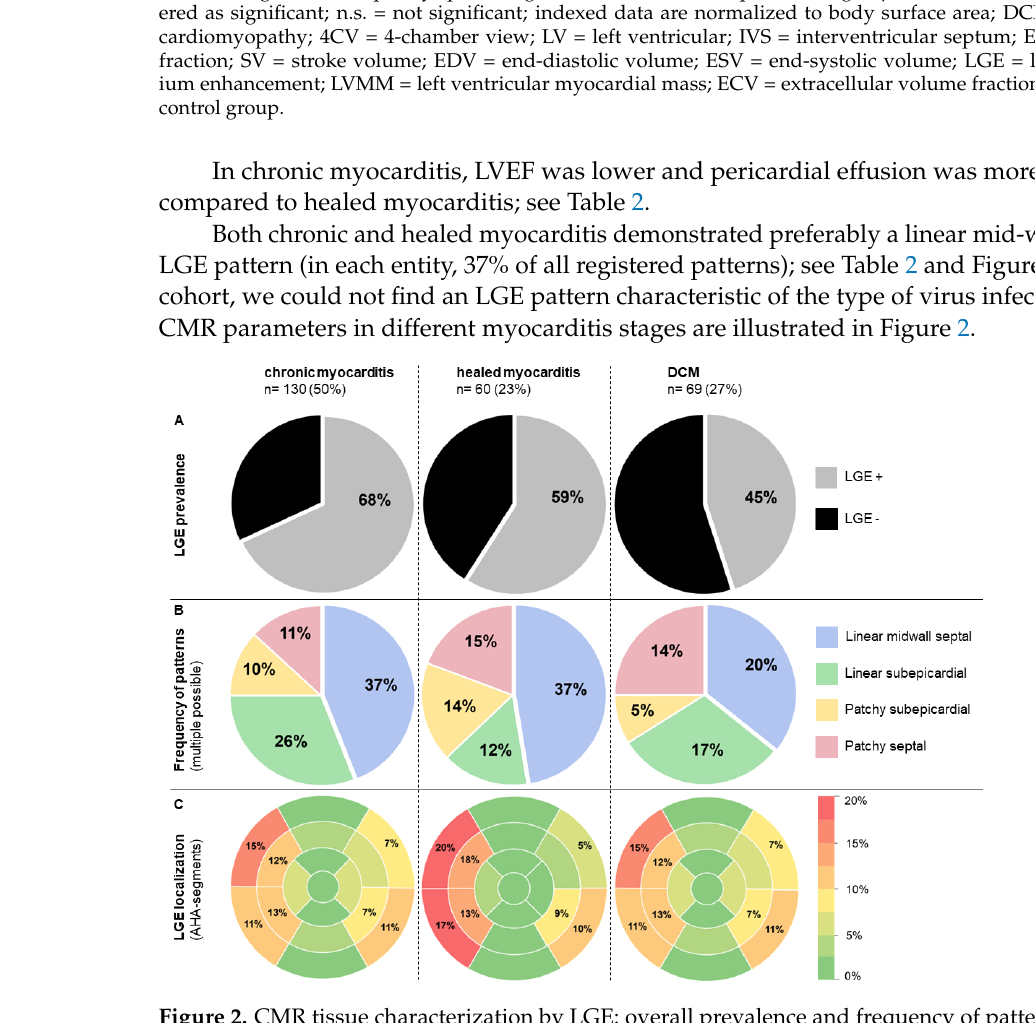
Figure 2. CMR tissue characterization by LGE: overall prevalence and frequency of patterns as well as the frequency of LGE localization per AHA-Segment. ( A ) The prevalence of LGE and ( B ) frequency of various types of LGE patterns in different histological stages of lymphocytic myocarditis (chronic, healed) and DCM. Note the high percentage of linear septal LGE in all groups. ( C ) Distribution of LGE localization (percentage %) using heat-mapped cardiac segmentation models for the different myocarditis stages and DCM. Only LGE patterns with a prevalence ≥ 5% are numbered.